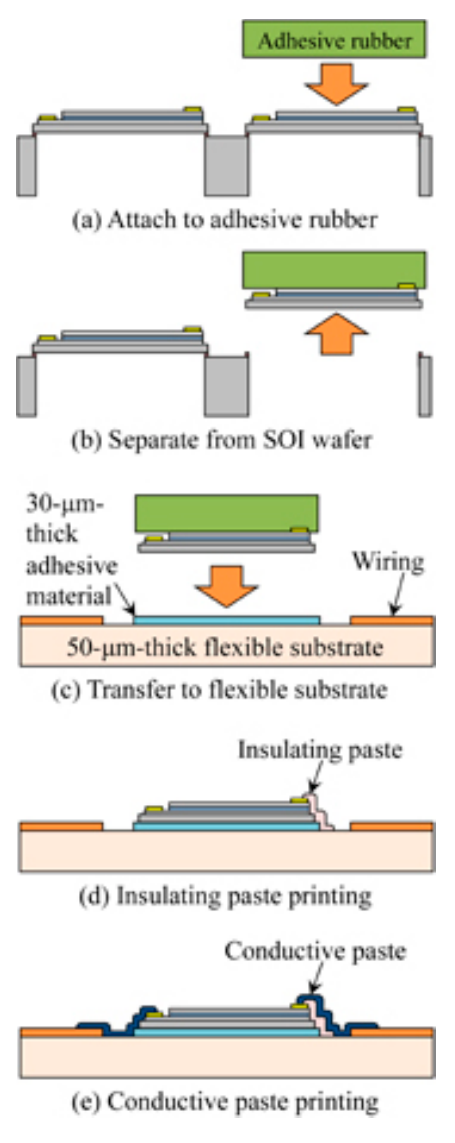
Figure 2. A schematic of the transfer printing process demonstrating the multi-step approach of patterning the device on a handle wafer followed by the release and transfer of the device to a flexible substrate using an elastomeric stamp or adhesive. From [79] (Copyright 2015 The Japan Society of Applied